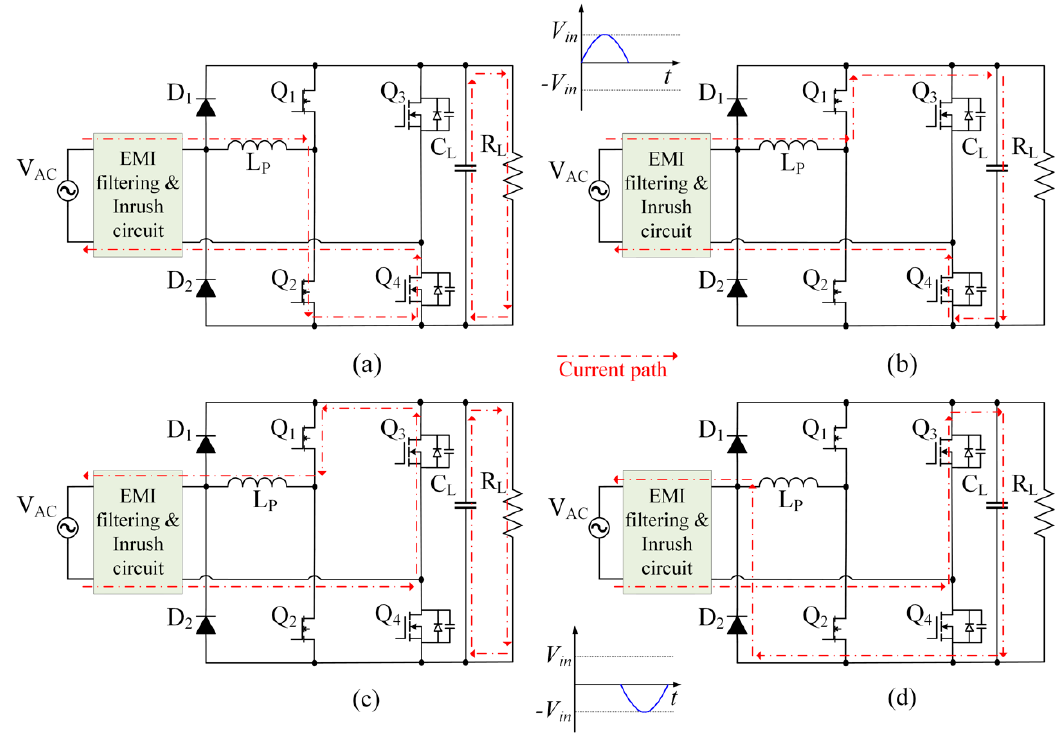
Figure 3. Current flows during positive and negative AC half cycles: ( a ) positive AC half-cycles from 0 to DT s ; ( b ) positive AC half-cycles from DT s to T s ; ( c ) negative AC half-cycles from 0 to DT s ; ( d ) negative AC half-cycles from DT s to T s .